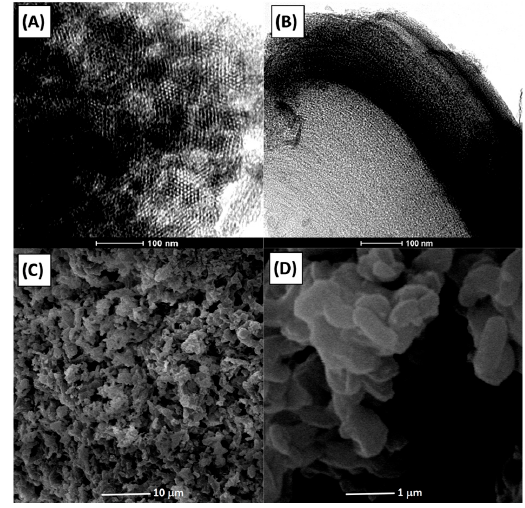
◦ 2 O 3 -n calcined at 700